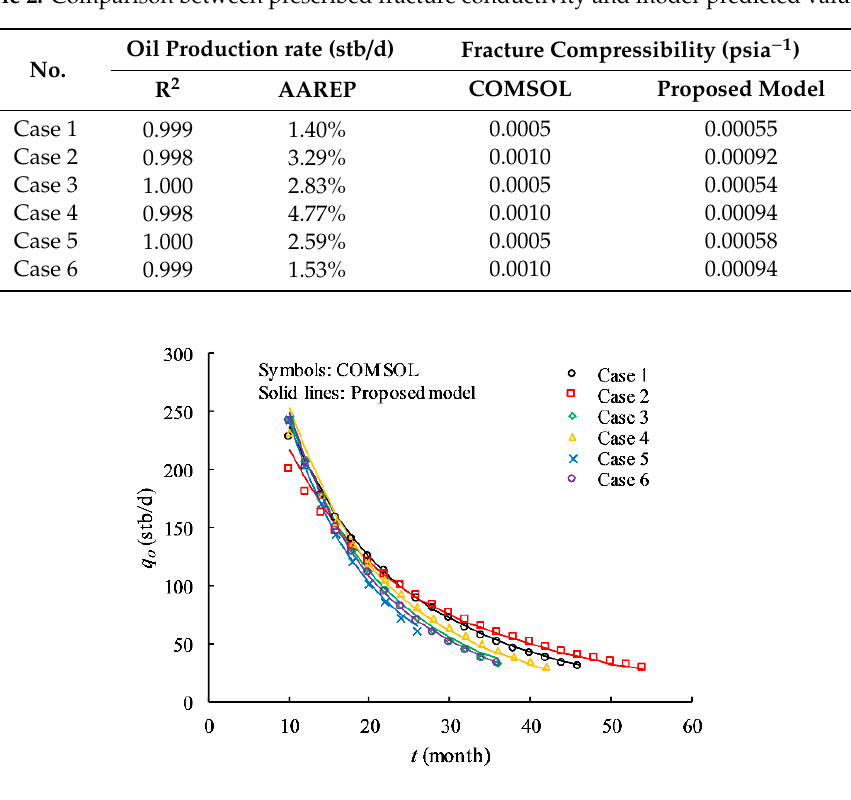
Figure 5. Comparison between the model-predicted production rate and the simulation result.